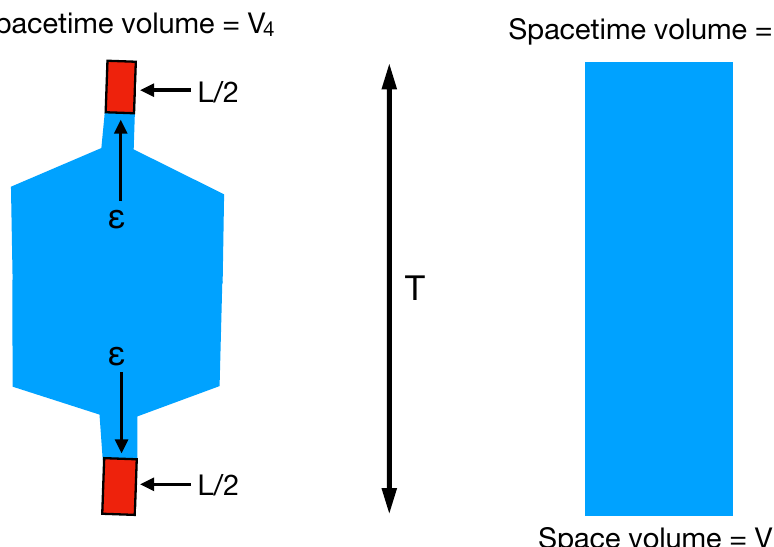
Figure 14. Left : a torus (opposite sides identified) with a pinch. Right : a torus where φ is constant in horizontal direction and uniformly increases from 0 to δ from bottom to top. The two tori are assumed to have the same vertical length T and the same spacetime volume V 4